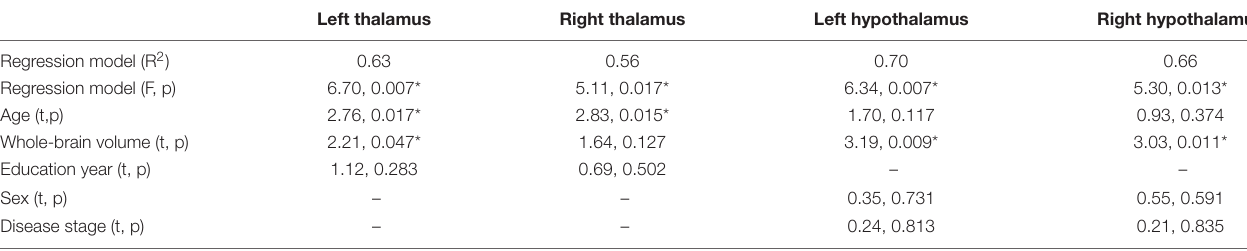
TABLE 3 | Multiple linear regression of brain volumes and clinical characteristics in ALS.